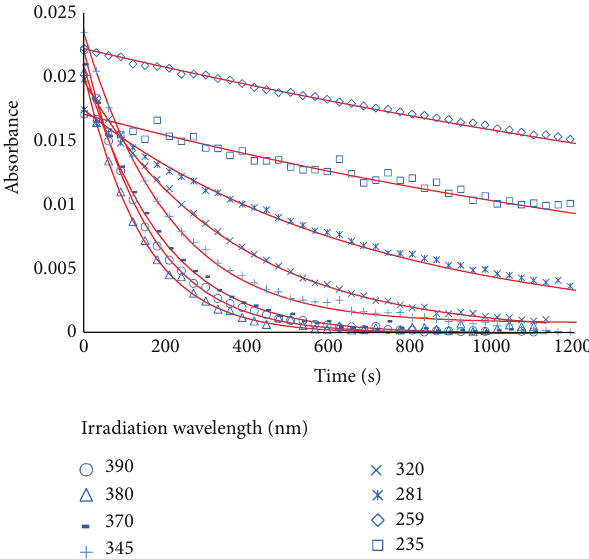
Figure 2: The photokinetic traces of NIS in ethanol (7.84 × 10 −6 M) at 𝜆 irr = 235 ,259,281,320,345,370,380,and390 nmandobservedat = 390 nm. The symbols represent the experimental data while 𝜆 obs the lines represent the model fitted traces using the appropriate model